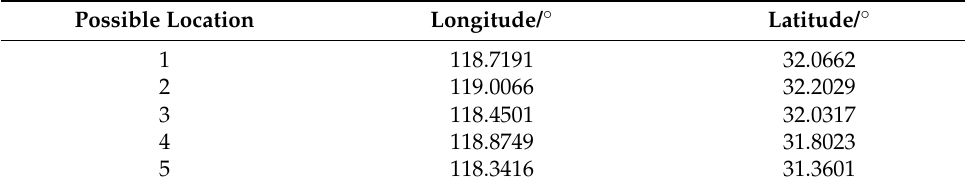
Table 6. Optimized locations within a 30 km rescue radius.